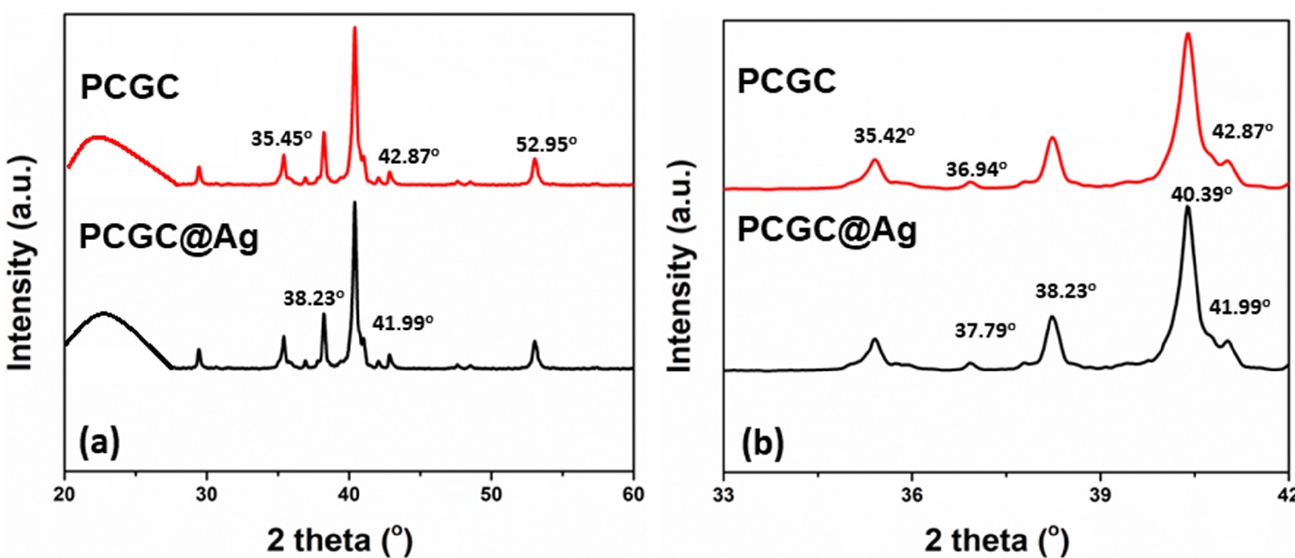
Figure 4. The amorphous and crystalline behavior was determined by XRD: ( a ) with 2 θ ranging from 20° to 60°; and ( b ) with 2 θ ranging from 33° to 42°.